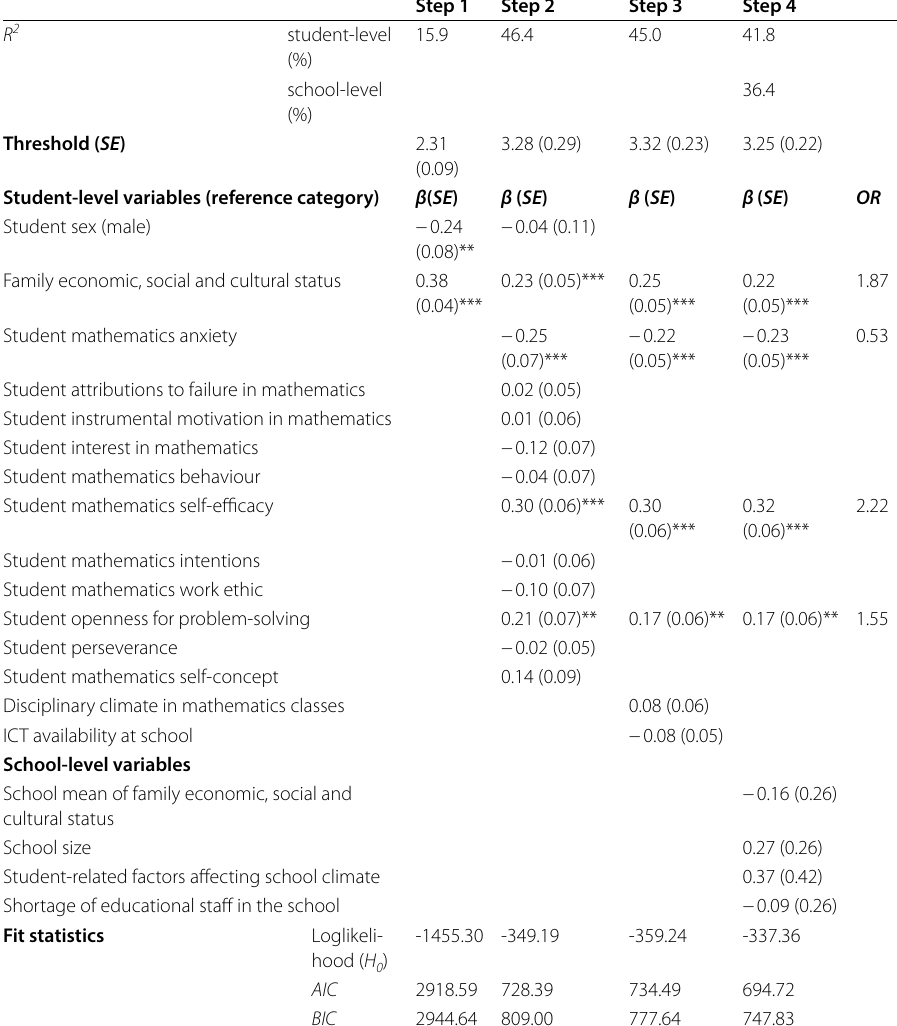
Table 5 Hierarchical two-level binary logistic regression model for high achievement in mathematics, PISA